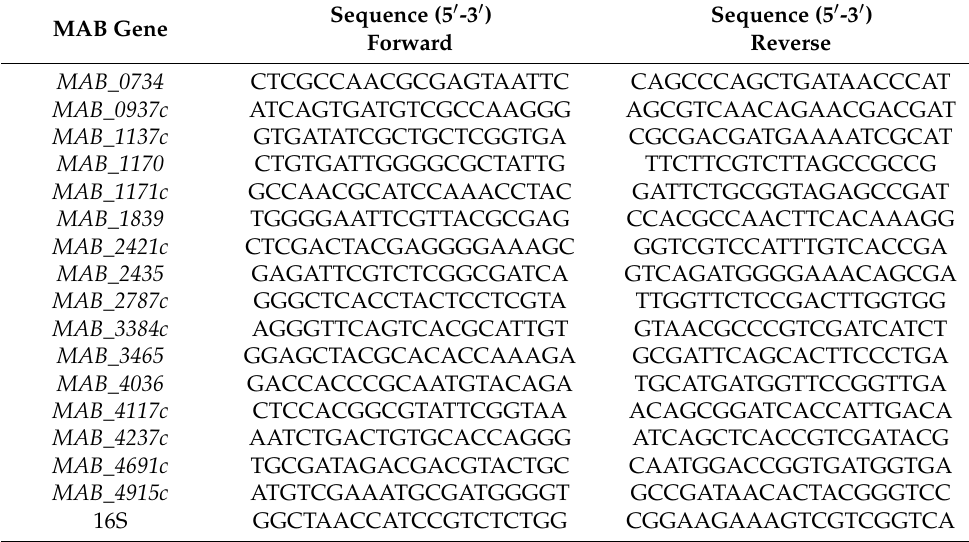
Table 2. Primers used in this study for the qRT-PCR analysis of the transport genes in the MAB clinical isolates. Sequence (5 (cid:48) -3 (cid:48) MAB Gene